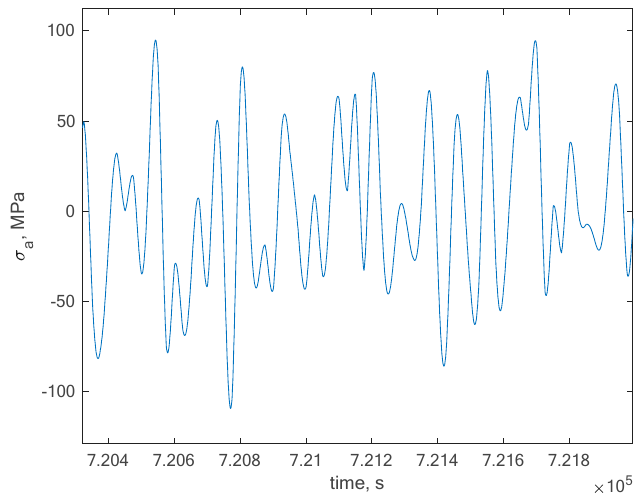
Figure 7. Transformed original stress signal in order to obtain a zero mean stress characteristic.